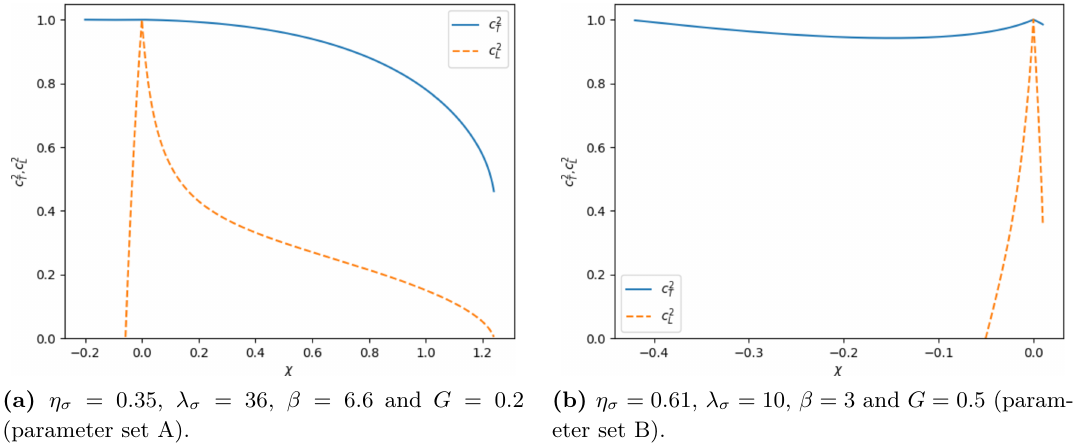
Figure 6 . The sound speeds as a function of χ . Again, the functions are equal and discontinous at , ∀ χ . This appears to always be true for superconducting χ = 0 . Notice that in both cases c 2 ≤ c 2 L T strings, although we have not found an analytic argument to prove